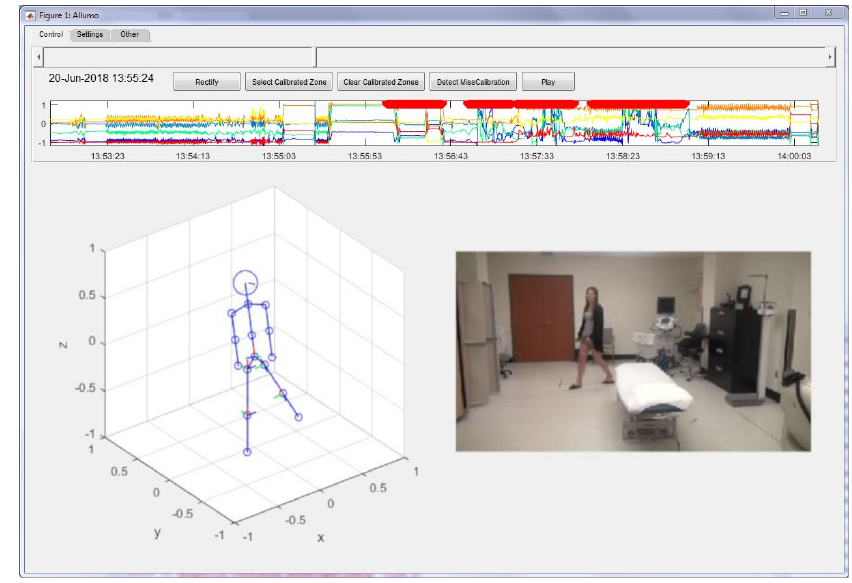
Figure 1. Main interface of the